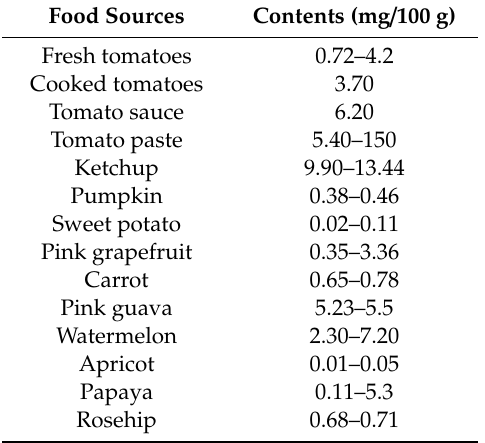
Table 1. Lycopene content in di ff erent